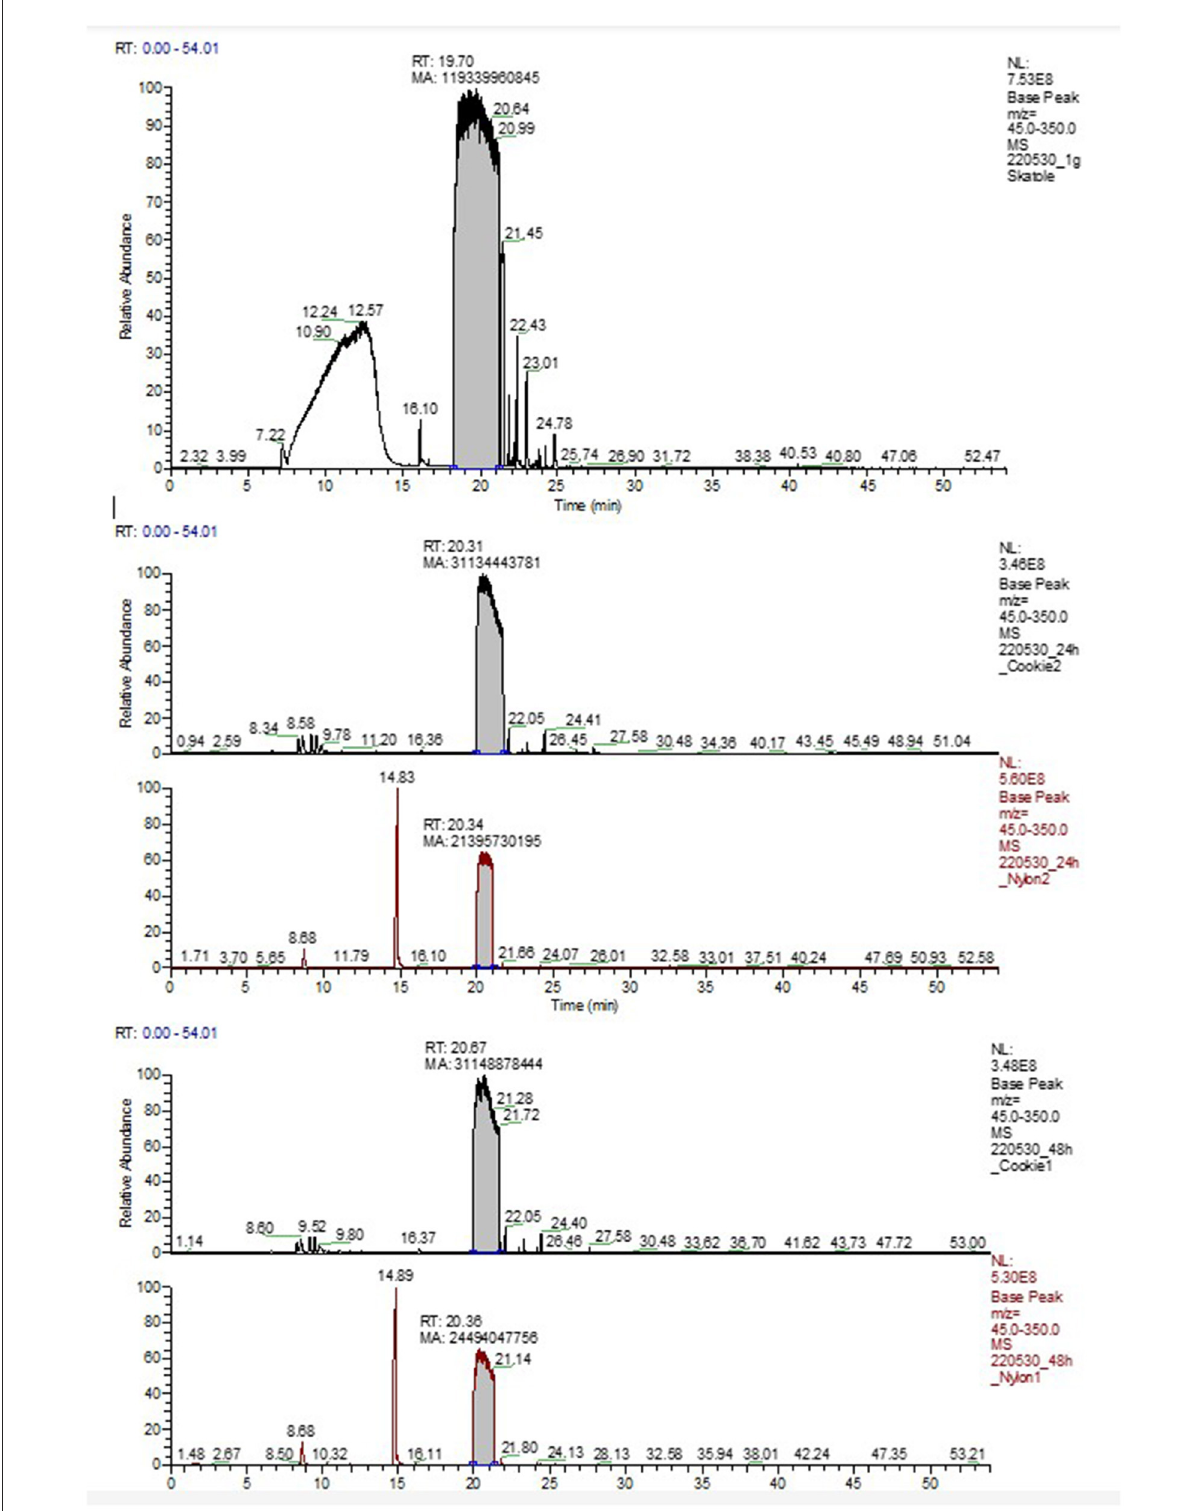
FIGURE4 Results of head space analysis over EVA cookies or nylon plastics. Top graph (A) is only skatole (no plastic carrier) which was run as a control sample. Note that Skatole peaks at about 20min. Other peaks represent unknown molecules that are found in air over the samples. Graphic B represents EVA cookies at 24h; C represents Nylon skatole release at 24h; D represents EVA cookie release of skatole at 48h and E represents nylon skatole release after 48h. Plastic samples were placed in the university nursery at 32C as is standard procedure on commercial farms. Graphs are representative